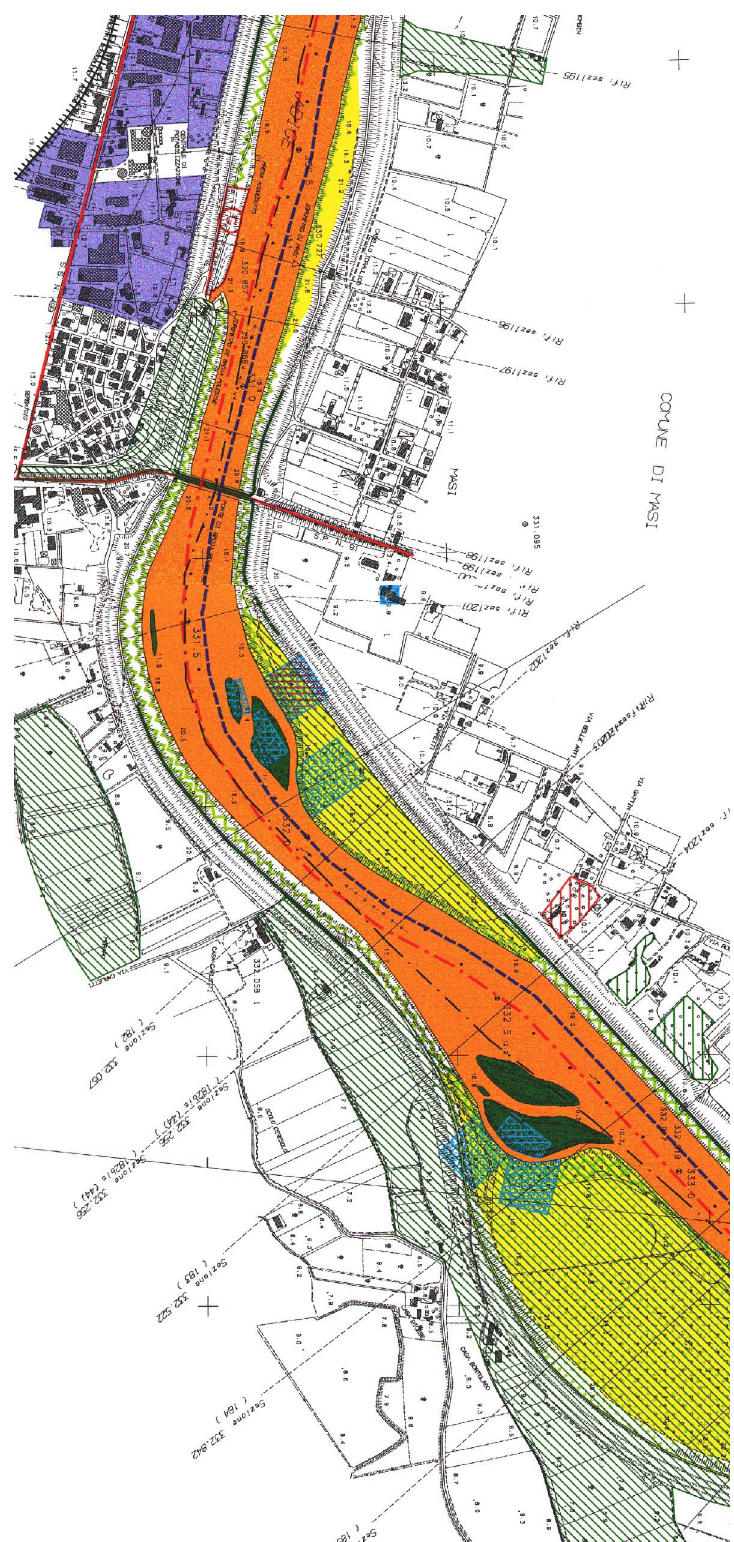
FIGURE 9. Map of quality, degradation, and risks for stretch